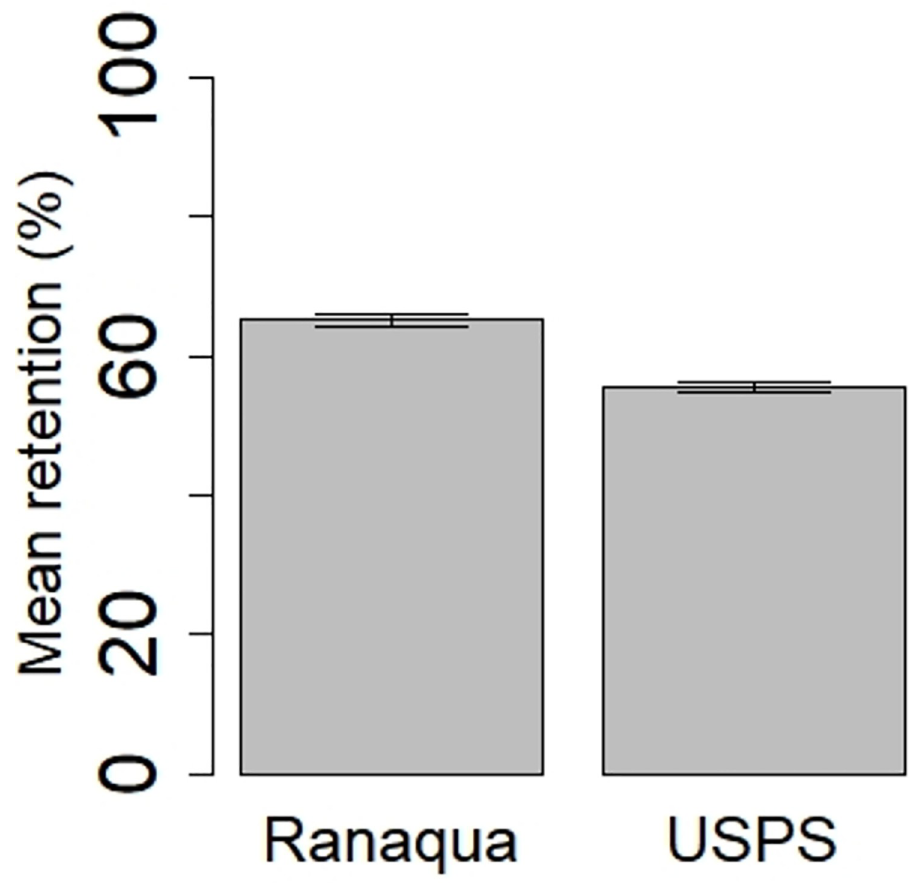
Fig 6. Estimated annual retention means ± standard